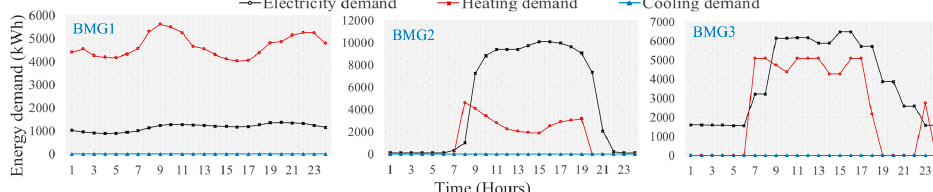
Figure 4. Electricity, heating, and cooling demand profiles of BMGs in winter season.